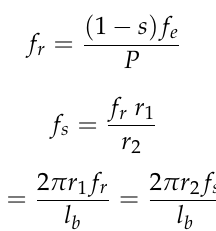
Figure 6. Steps for numerical analysis.